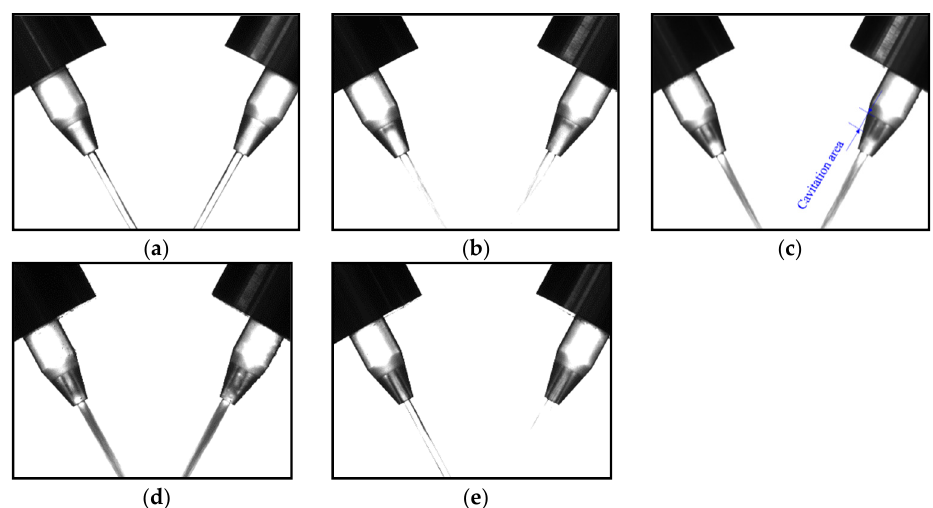
Figure 9. The cavitation state of the flow field in the 1 mm orifice when the aspect ratio is 4 in the experiment. ( a ) 0.2 MPa. ( b ) 0.3 MPa. ( c ) 0.35 MPa. ( d ) 0.4 MPa. ( e ) 0.8 MPa.